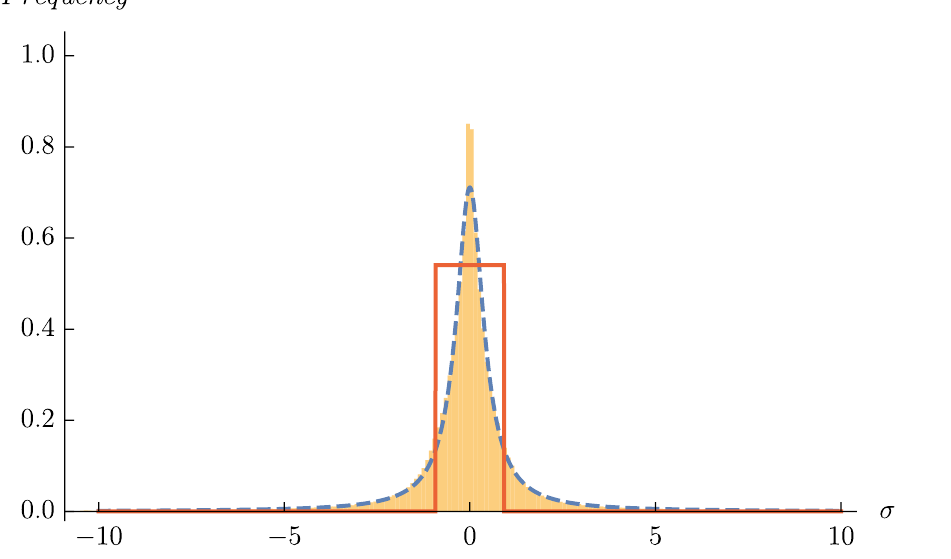
Figure 3 . Histogram of 43776 solution points at 6 points NMHV taken from 7559 di(cid:11)erent random momenta. The blue dashed curve is CauchyDistribuion[0,0.447] , and the red solid curve is an approximation with the uniform distribution U ([ (cid:0) 0 : 894 ; 0 :